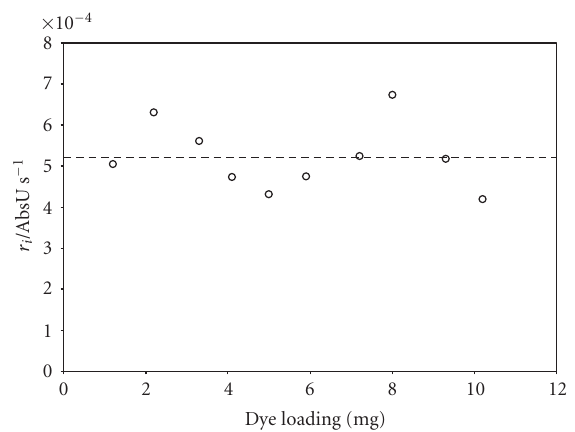
Figure 3: The variation in the initial rate of reduction ( r i ) of a DCIP ink on Activ as the level of dye in the ink formulation is altered between 1 and 10 mg. The dotted line indicates the calculated average r i of 5.21 × 10 − 4 AbsU s − 1 .